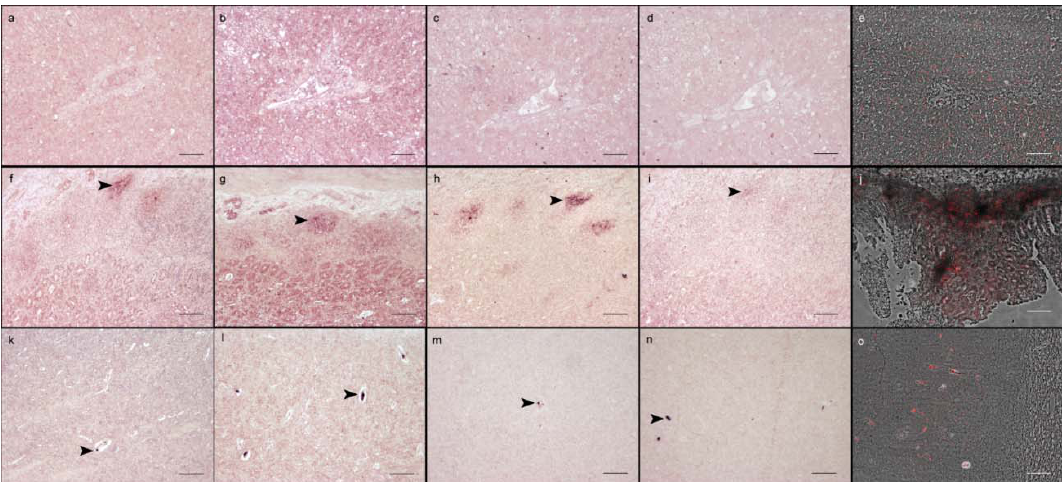
Figure 2. Overview of signals after applying the FISH ‐ RNA probe mix. ( a ) Using the BovHepV specific FISH ‐ RNA probe mix, several hepatocytes of a BovHepV infected bovine, stained positive for BovHepV (bar: 100 μ m); ( b ) SBV was detected in several neurons of the cerebrum using the SBV ‐ specific FISH ‐ RNA probe mix (bar: 100 μ m); ( c ) Single neurons of the cervical spinal cord stained positive for PBoV in a PBoV infected pig (bar: 100 μ m); ( d ) Cortical and medullary probe mix (0.20%; Figure 2b). Within the negative controls, including the negative animals and the lymphocytes of the pulmonary lymph node in an infected pig showed an intracellular PCV ‐ 2 specific signal (bar: 100 μ m).